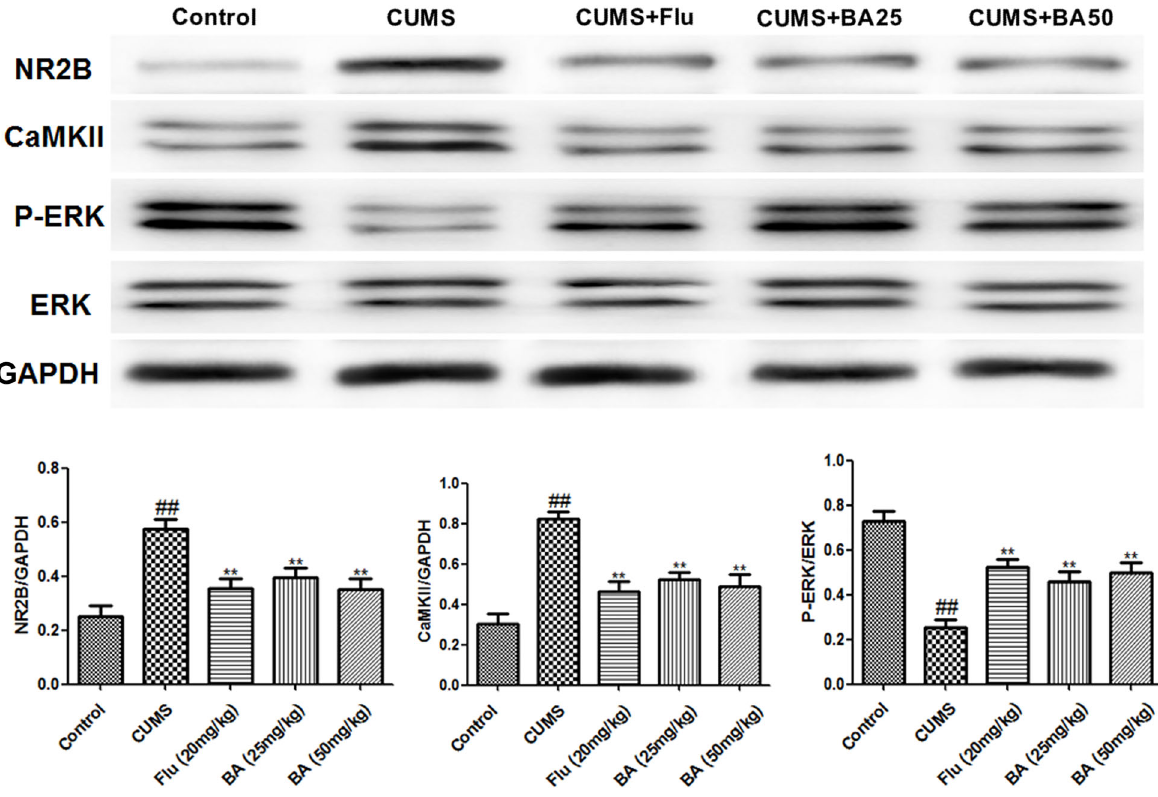
Figure 4. Baicalin (BA) downregulated NR2B and CaMKII and upregulated P-ERK1/2 expression in mice subjected to CUMS (chronic unpredictable mild stress). Data are reported as means ± SE (n=8). ## P o 0.01 vs control; **P o 0.01 vs CUMS (ANOVA). Flu: fl uoxetine.